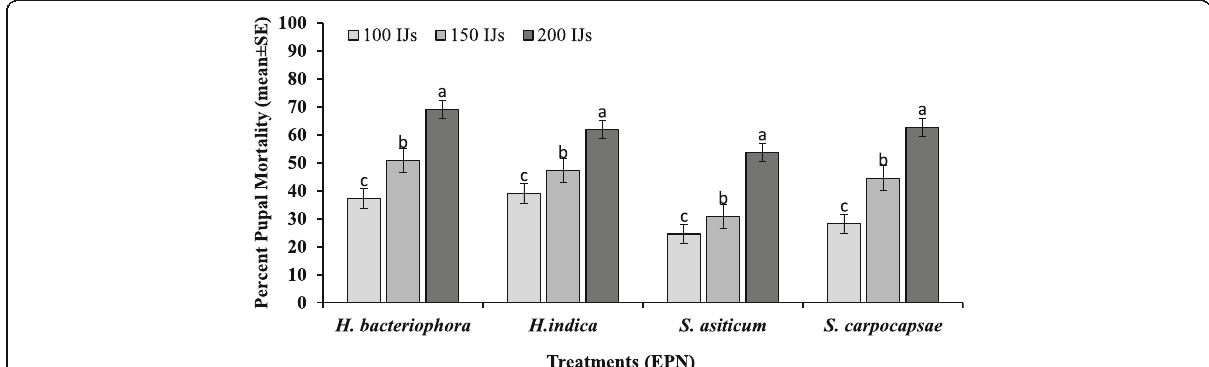
Fig. 1 Corrected percent mortality (mean ± SE) in Bactrocera dorsalis pupae after 10 days of treatment with Heterorhabditis bacteriophora , H. indica , Steinernema carpocapsae , and S. asiaticum at different